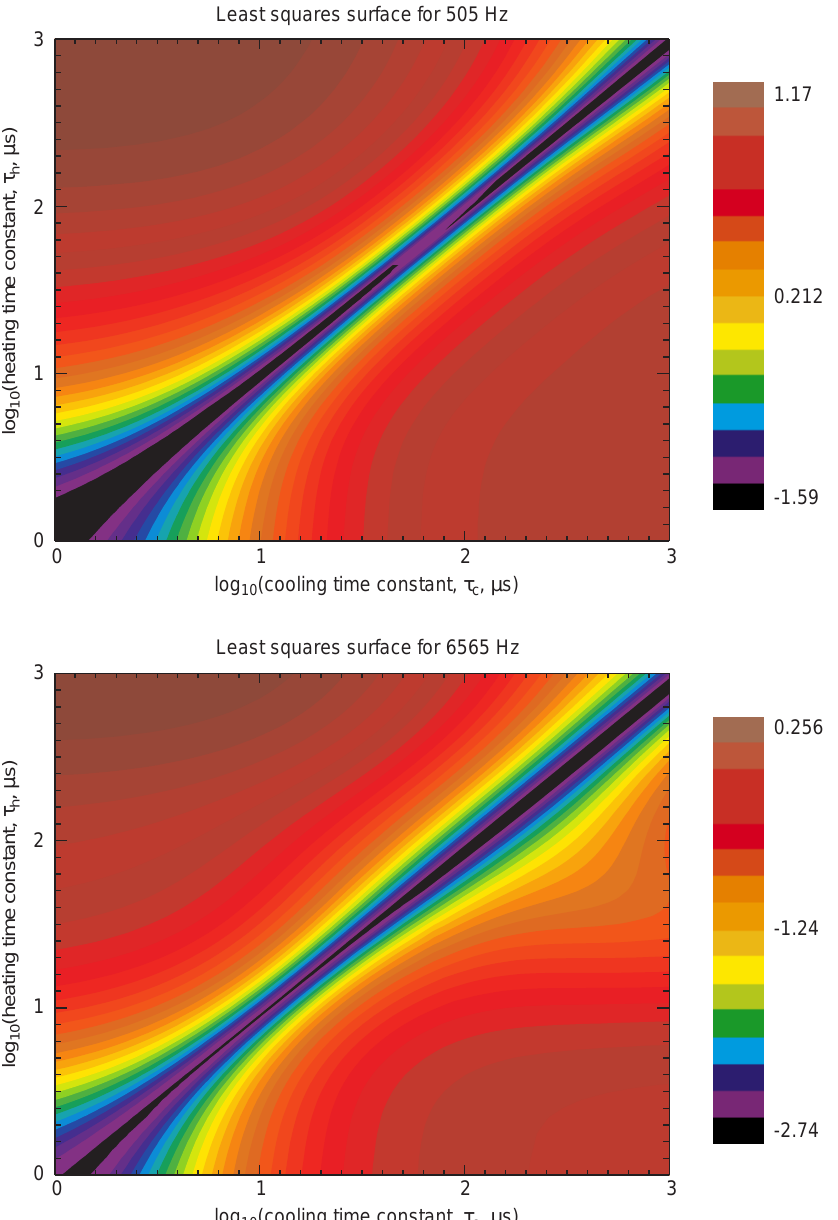
Fig. 9. Contours of log (least squares 10 error) in fitting the experimental magnetic field strength data, measured as a function of duty cycle, to the estimates of the field strength derived theoretically from the ionospheric heating and cooling time con- stants. Evaluations for ODD harmonics. Upper panel : fundamental frequency, 505 Hz. Lower panel : 13th harmonic,